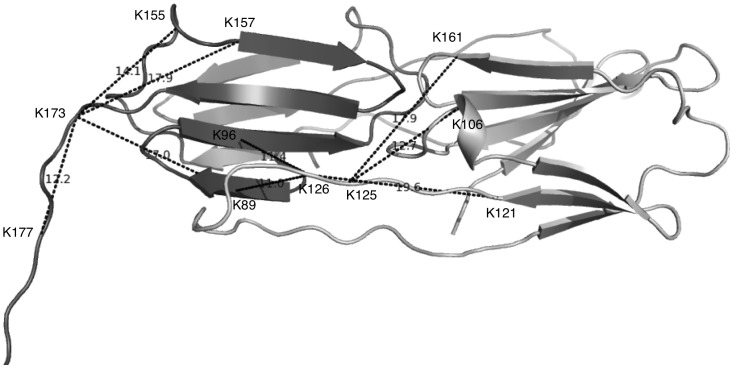
Intra- and inter-monomeric crosslinking distinguished by mixed isotope labeling.MS-spectra obtained by crosslinking of 14N/15N oligomers of Hsp21 showing (A) a crosslink formed within the monomers resulting in two peaks with 14N-14N and 15N-15N (designated as intra-monomeric (intra) in Table 1) and (B) a crosslink formed between the monomers resulting in a four peak pattern with 14N-14N, 14N-15N, 15N-14N and 15N-15N (designated as inter-monomeric (inter) in Table 1). The inter-monomeric crosslinks can originate from crosslinking within or between the oligomers. The two-peak pattern with 14N-14N and 15N-15N could in principle also originate from inter-monomeric intra-dimeric crosslinking since stable dimers may be the exchanging subunits [25], [26].